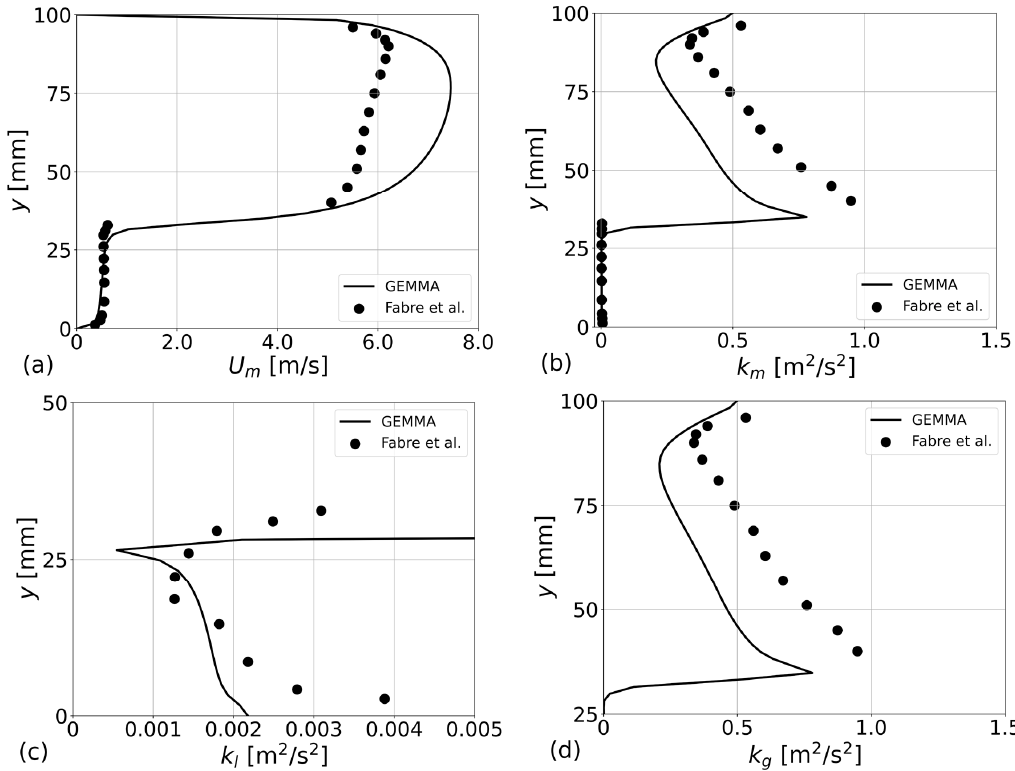
Figure 5. Predictions of GEMMA compared against the 400 experiment of Fabre et al. [30]. Profiles along the height of the channel of: ( a ) velocity; ( b ) turbulence kinetic energy; ( c ) turbulence kinetic energy in the liquid phase; ( d ) turbulence kinetic energy in the gas phase.